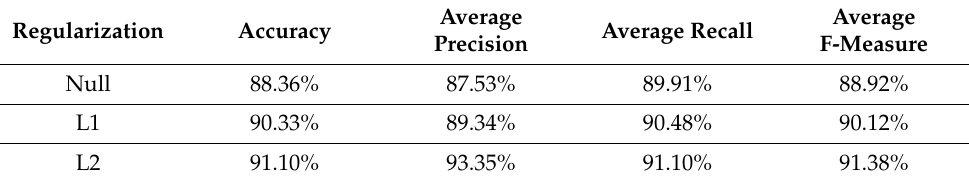
Table 4. The performance of the OSR model based on